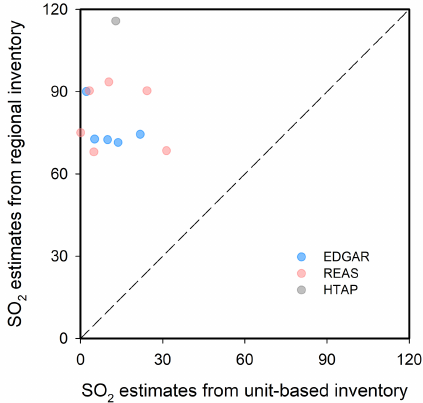
Figure 9. Comparison of SO 2 emission estimates from unit-based and regional emission inventory for power plants that are not de- tected by